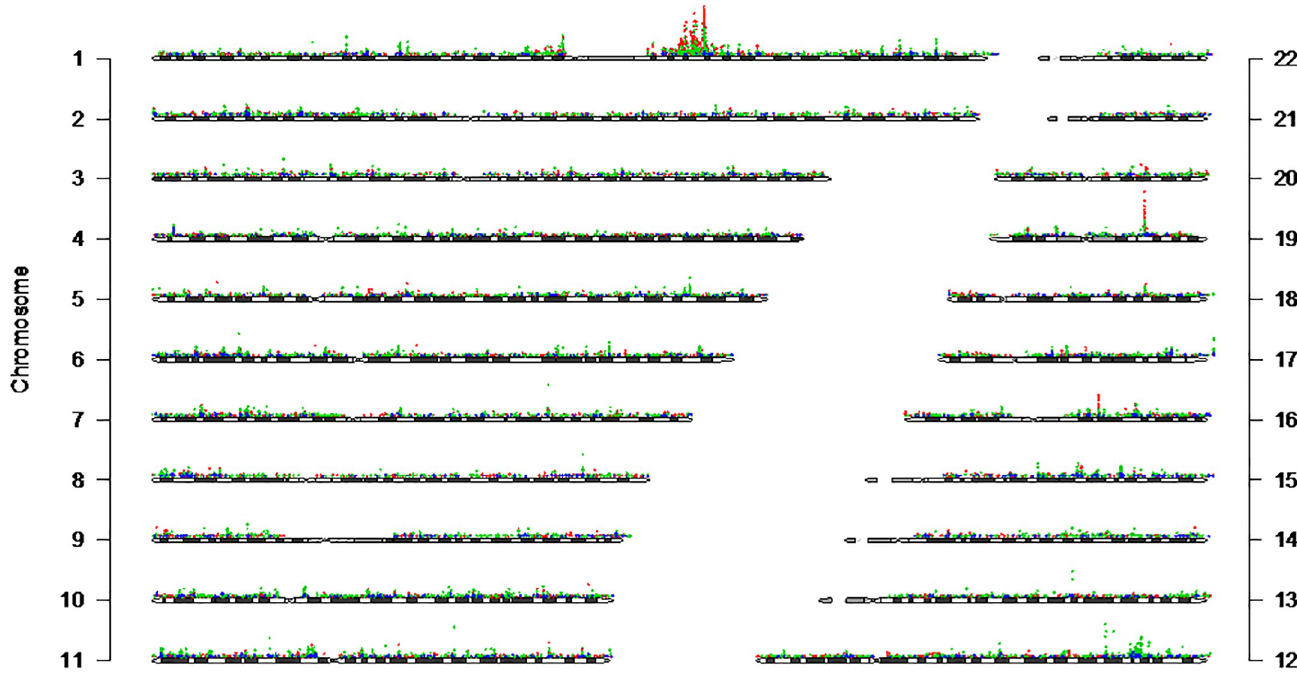
Fig 2. All genetic tests of association results, by PAGE study. Results from all tests of association for SNPs with a minor allele frequency > 1% regardless of phenotype at p < 5x10 -4 were plotted across chromosomes 1–22. Each dot on the plot represents the − log10(p-value) for the test of the association, and each of the three PAGE studies is plotted with a different color, Multiethnic Cohort (MEC) in blue, Women’s Health Initiative (WHI) in green, and Atherosclerosis Risk in Communities (ARIC) in red. The most significant p-value plotted here is 8.01E-44 for OLFML2B rs6676438 and (natural log) white blood count in ARIC (see Table 2). The y-axis for each chromosome is the − log10(p-value), and the x-axis is chromosomal base pair